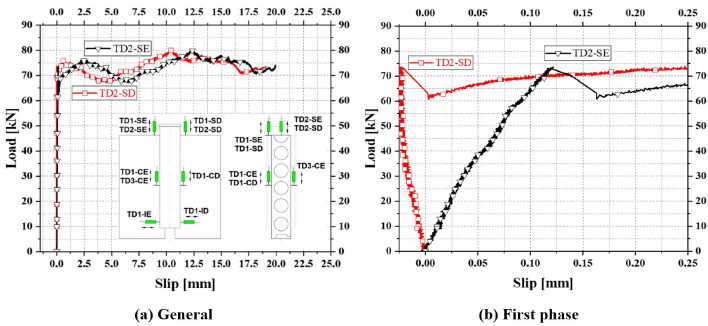
Fig. 9: Load versus slip curves in point 2 at the top of specimen